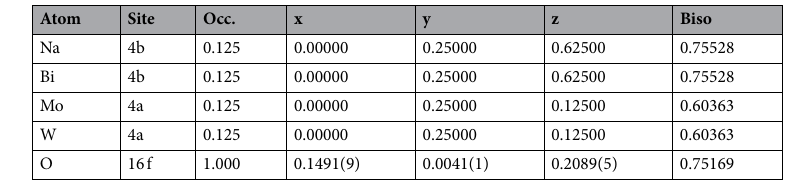
Table 1. Refined atomic fractional coordinates from XRD data of the (Na 0.5 Bi 0.5 )(Mo 0.5 W 0.5 )O 4 ceramic and the cell parameters are a = b = 5.281 (5) Å, c = 11.550 (6) Å with a space group is I 4 1 /a